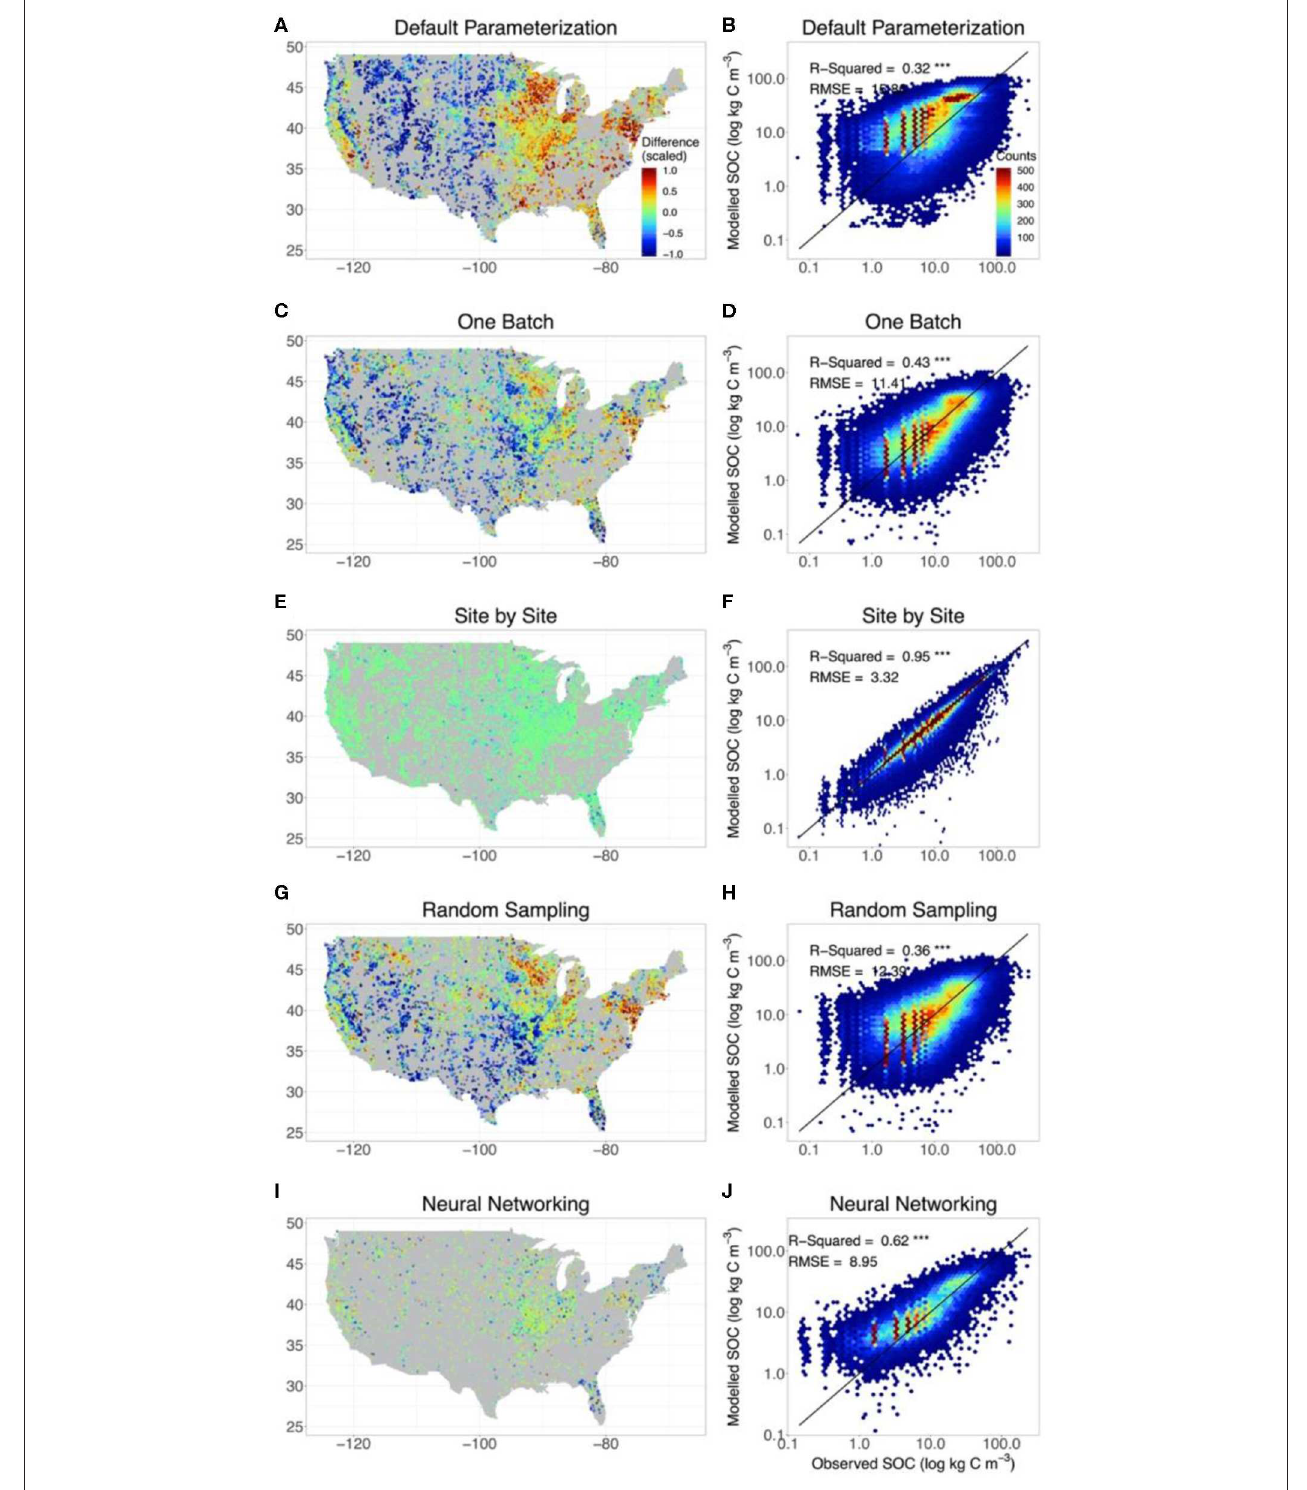
FIGURE 2 | The agreement between observed and modeled SOC content with different methods. For comparison, we also include the results from CLM5 with default parameterization (A,B) and from the site-by-site data assimilation (E,F) . SOC estimates modeled by CLM5 at different depth of the model setting were extrapolated to the depths of observations to evaluate model performance. The left panels indicate the deviation of the modeled SOC storage from the observation of the whole profile